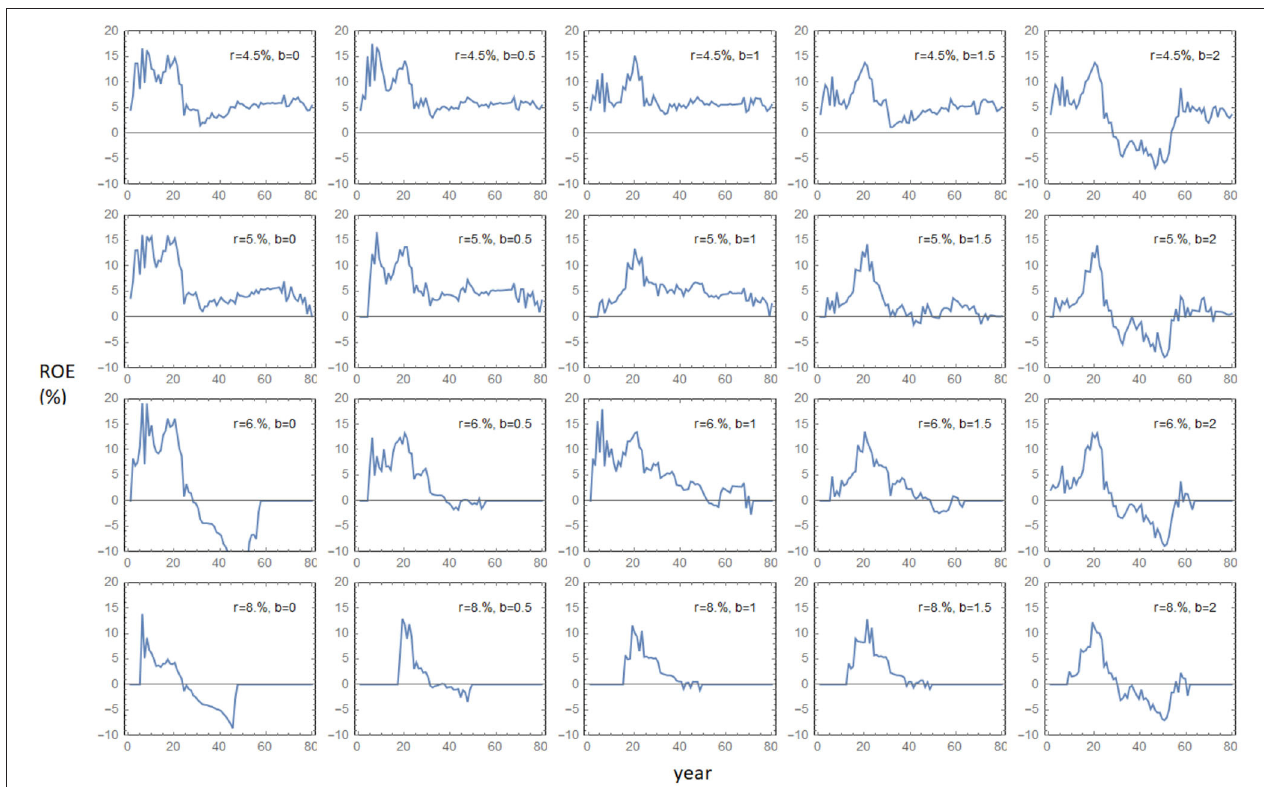
FIGURE 6 | Return on equity (ROE) for all companies over the full-time period of 80 years in the base case [ f = 30% and i = 400M e ]. f is the fraction of an investment financed by a company’s own capital and i is the initial capital in a company’s bank account. r is the hurdle rate agents use and b is the expected carbon tax